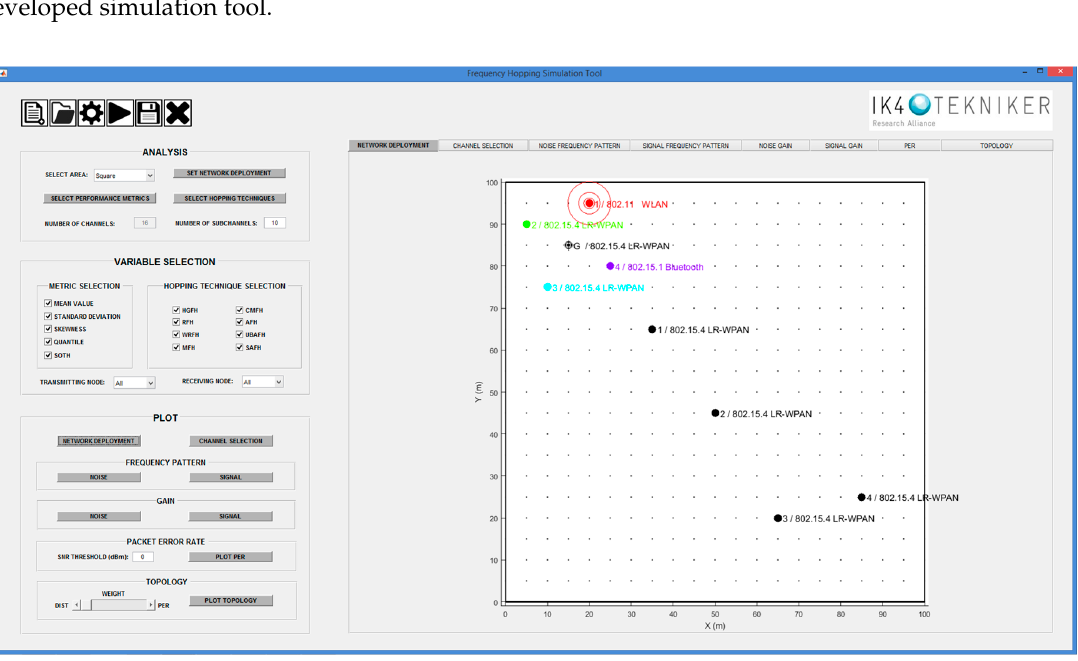
Figure 15. Different network topologies: ( a ) Single-hop: each node (black dots) communicates directly to the gateway (red dot); ( b ) Multi-hop: the nodes communicate to the gateway hopping through other nodes.